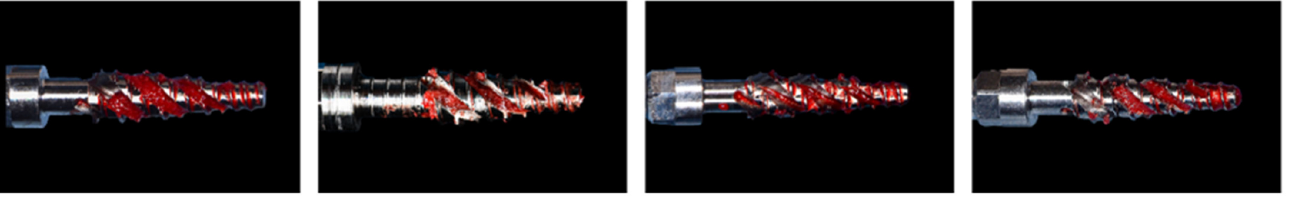
Figure 4. The novel osseoshaping tool upon withdrawal from the osteotomy site. Note the autogenous bone within the threads of the instrument.